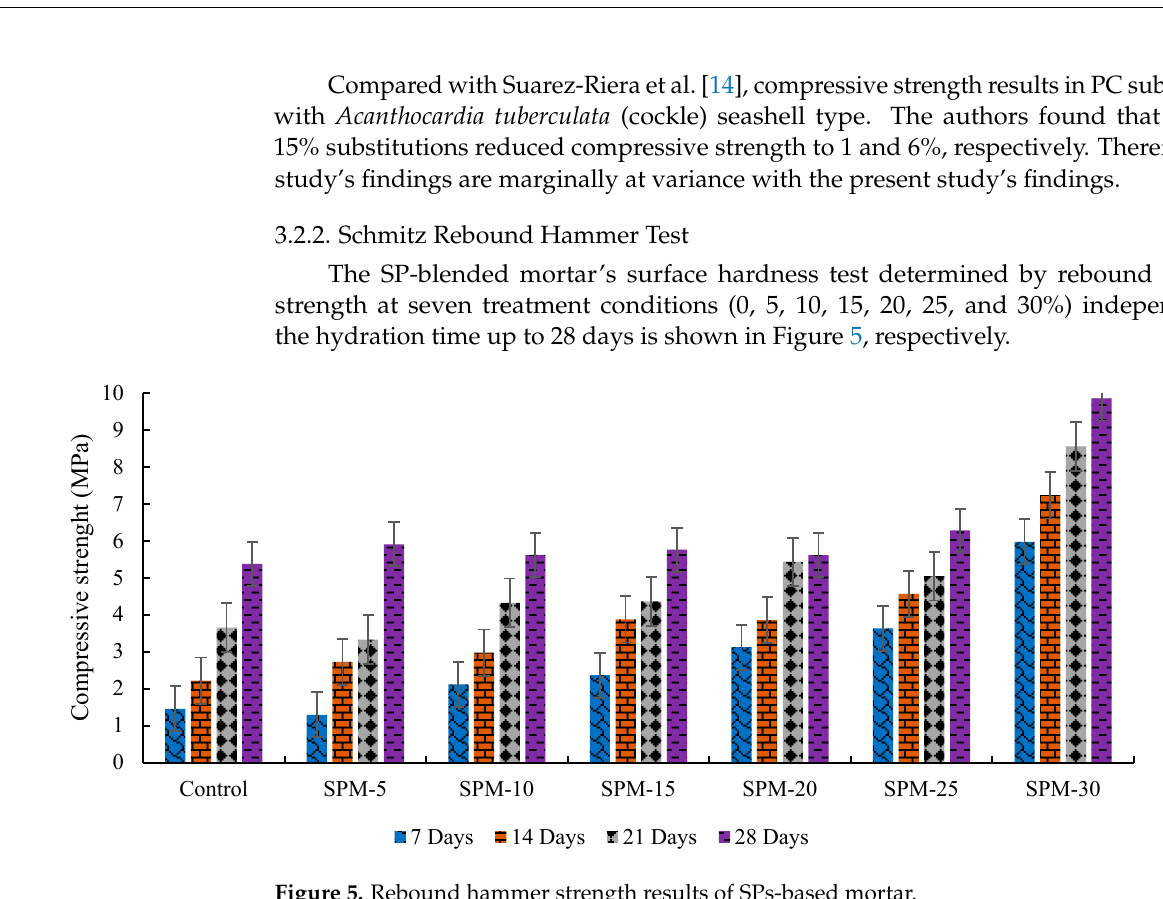
Figure 4. Compressive strength development of SPs-based mortars.